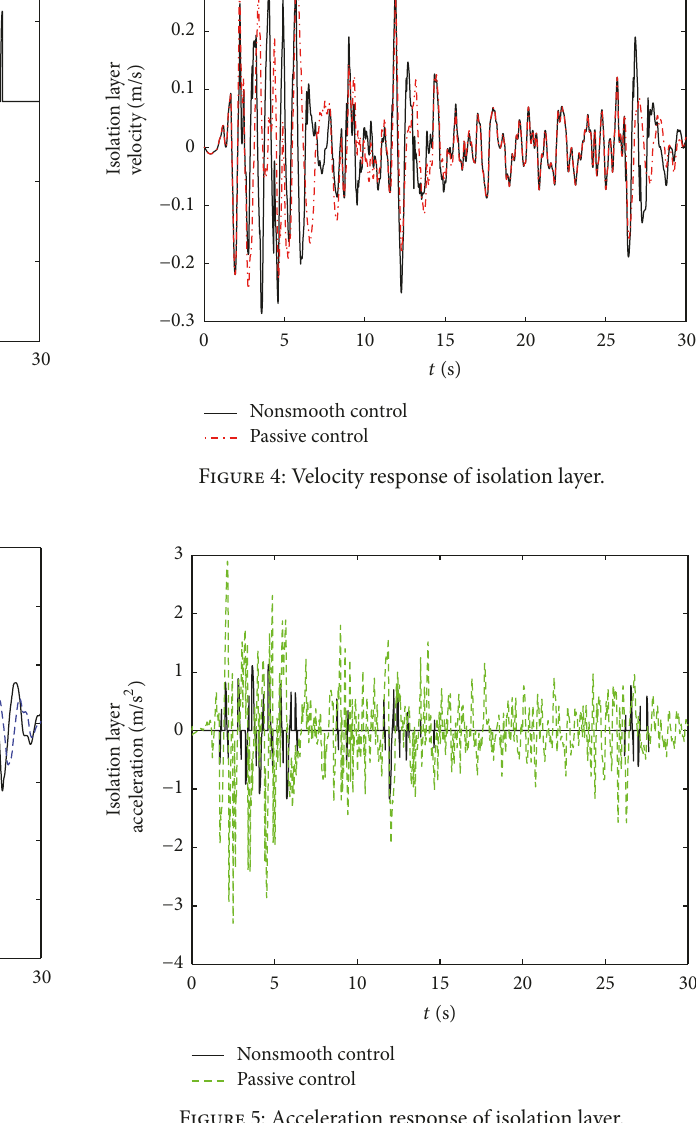
Figure 5: Acceleration response of isolation